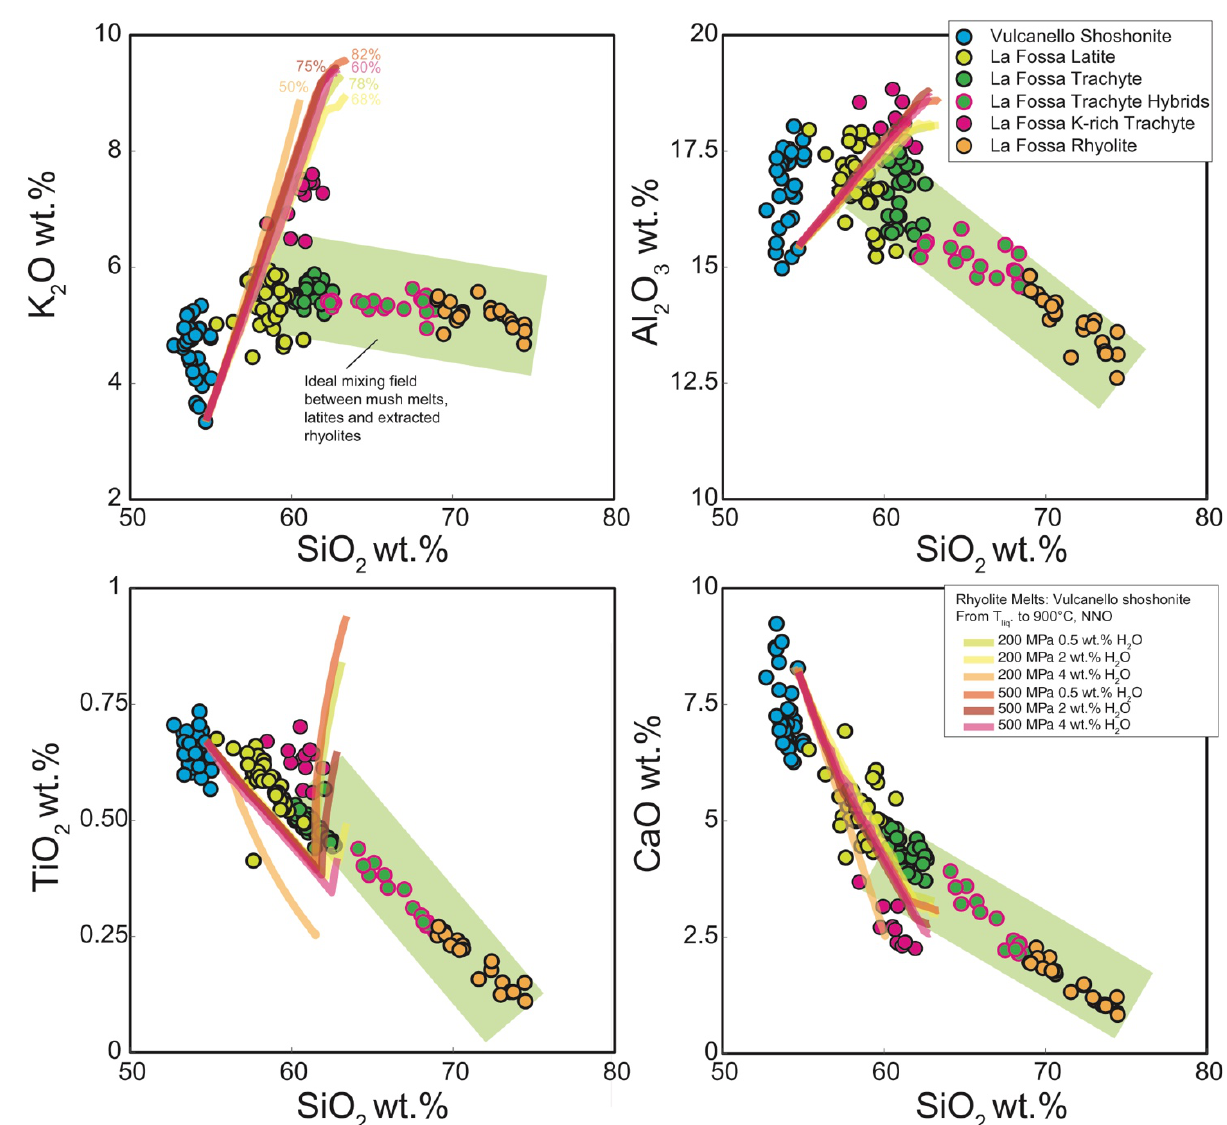
Figure 9: Thermodynamic modelling by Rhyolite-MELTS simulating assimilation of a sanidine-rich mush by the shoshonitic magma undergoing concurrent assimilation and fractional crystallization (Supplementary Table S10). Numbers at the end of each MELTS simulation refer to the amount of crystallization. The ideal mixing field between mush melts, latites and extracted rhyolite (same as Figure 8) is highlighted in green. Literature data sources as in Figure 2.